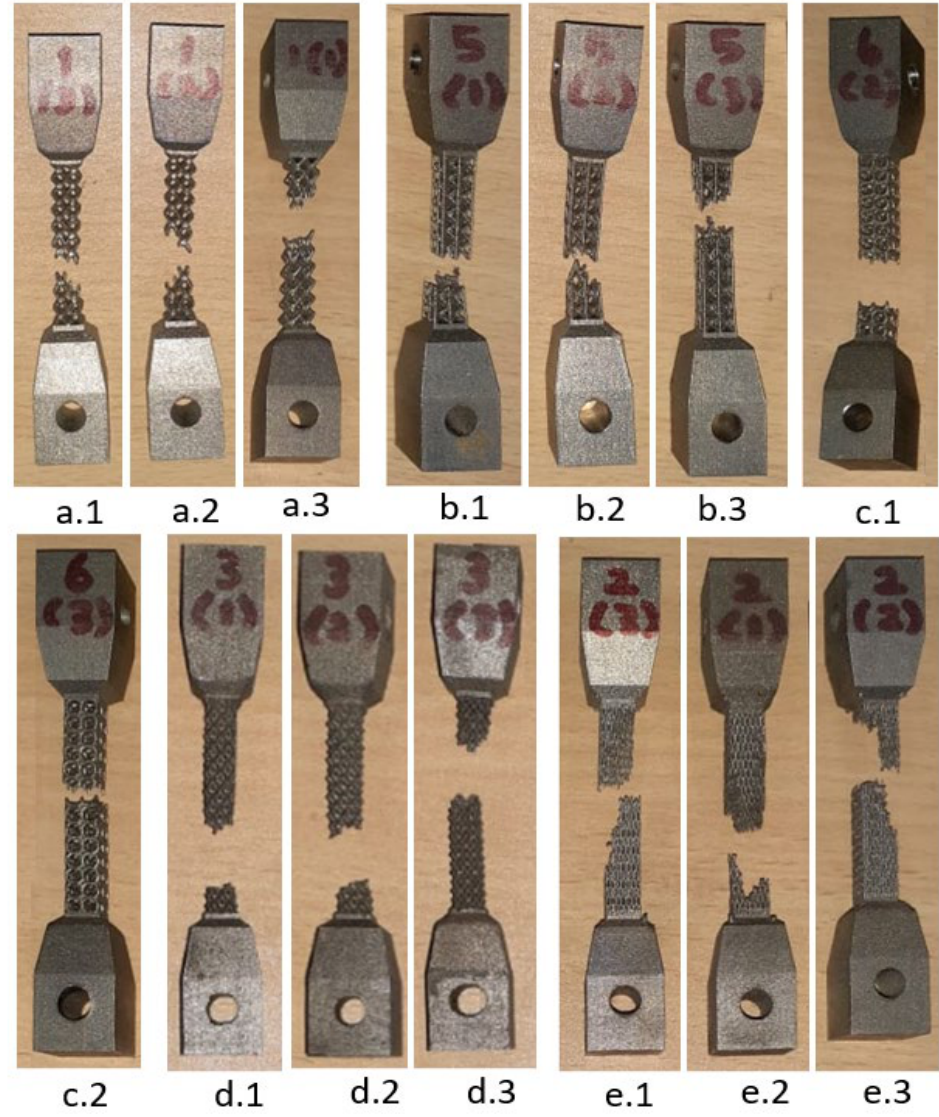
Figure 12. UTM test samples’ failure locations for various lattice geometry.